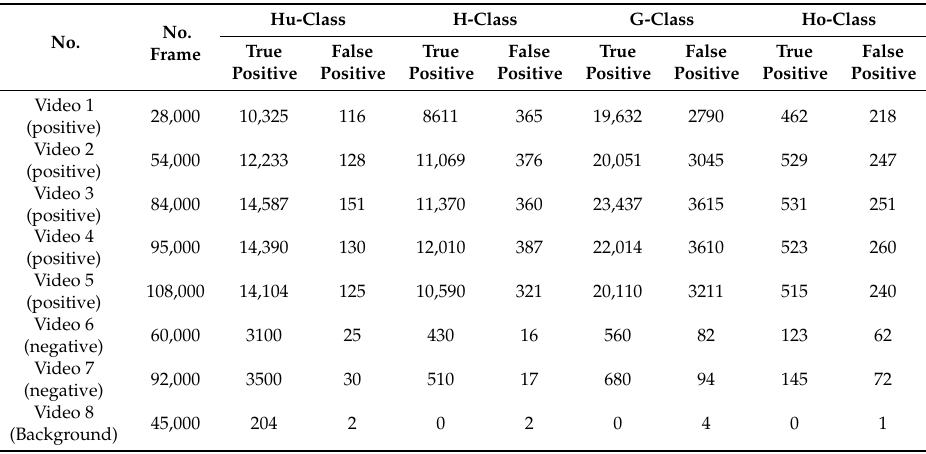
Table 3. Detection results for each class in eight